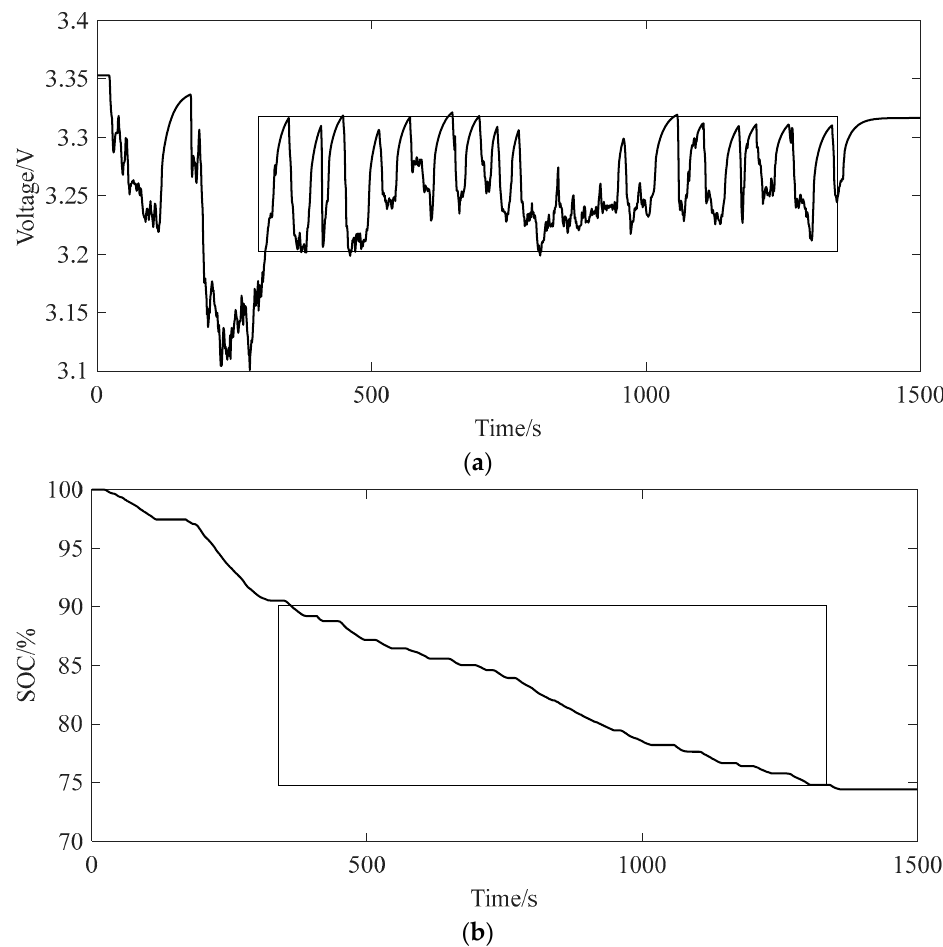
Figure 8. Voltage SOC changes under UDDS conditions. ( a ) Voltage under UDDS condition. ( b ) SOC under UDDS condition.